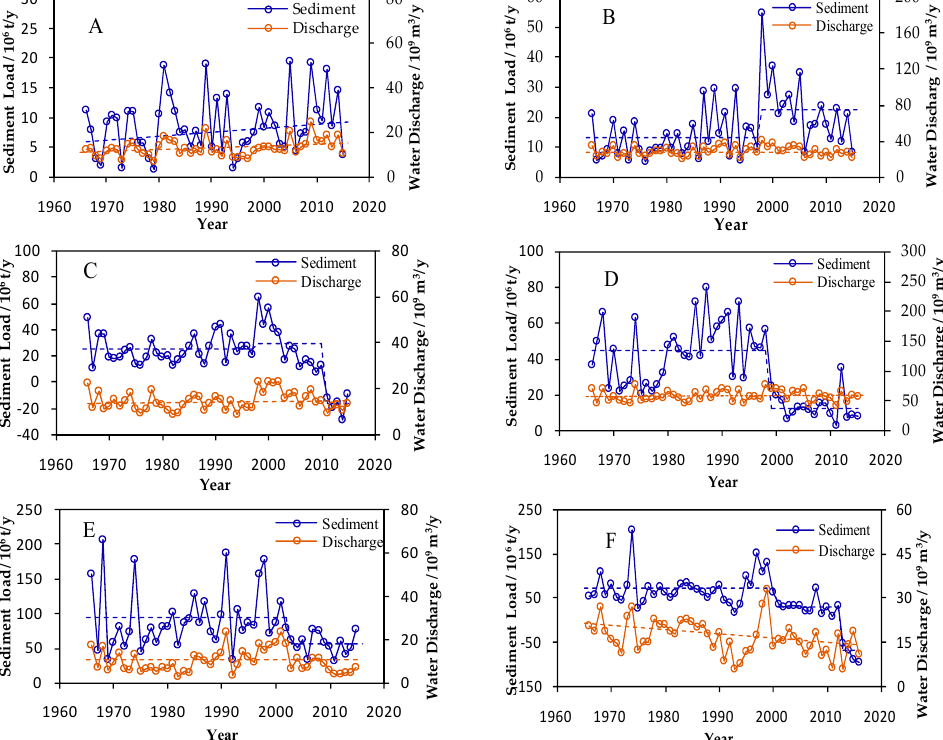
Figure 2. Results of variation in water discharge and sediment load in di ff erent regions of the Jinsha River Basin from 1966 to 2015 ( A : Upstream region of the Zhimenda Station; B : Region between the Zhimenda and Shigu Station; C : Region between the Shigu and Panzhihua Station; D : Yalong River Basin; E : Region between the Panzhihua and Huatan Station (excluding the Yalong River basin); F : Region between the Huatan and Pingshan Station). Table 4. Analysis results of water discharge and sediment load in each region at different periods. Water Abrupt Change Point Time Sediment Load Discharge Region /year /10 6 t Water Sediment /10 9 m 3 Upstream region of the Zhimenda Station